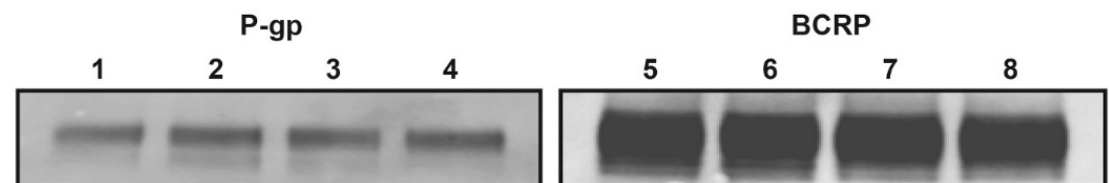
Figure 9. Effects of NO/NCX4040 (5 µ M) on P-gp and BCRP proteins in NCI/ADR-RES and MCF-7/MXR cells following 4, 24 and 48 h treatment. Lanes 1 and 5 are untreated controls, 2 and 6 at 4 h; 3 and 7 at 24 h; and 4 and 8 at 48 h. A representative Western Blot is shown. The uncropped Western blots have been shown in Figure S1.